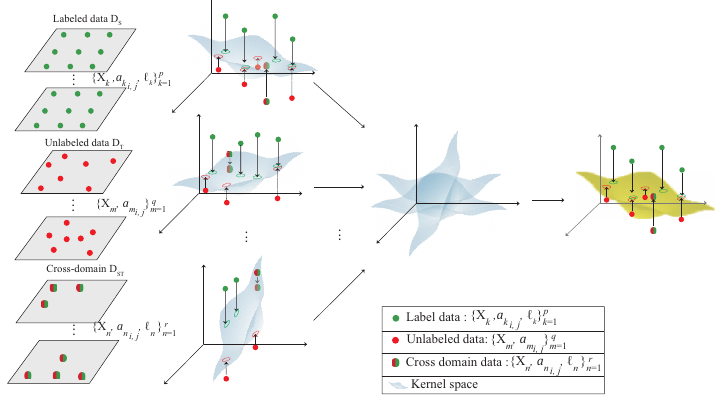
Figure 4. The multi-kernel